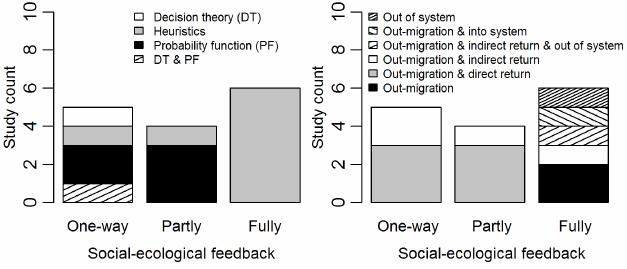
Fig. 5 . Type of social-ecological coupling and the decision rule used to model migration decisions (left) and the migration flow considered within the agent-based model